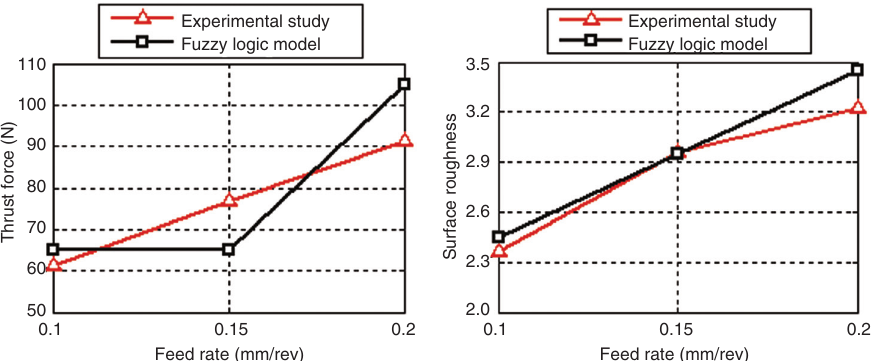
Figure 8 The effect on thrust forces and surface roughness of feed rates.